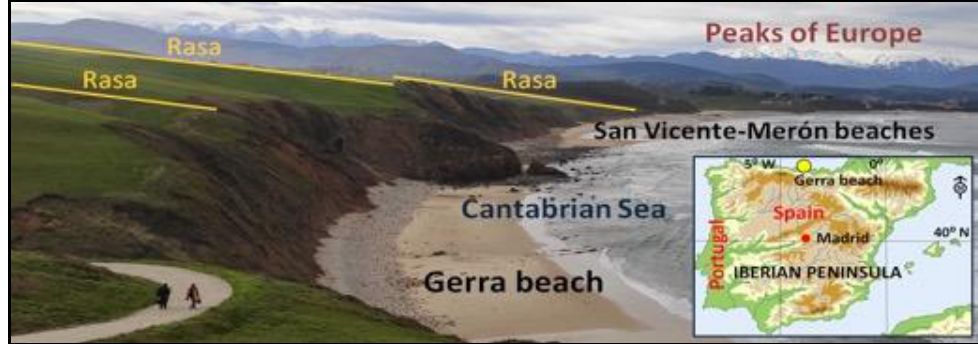
Figure 1. Gerra beach and San Vicente-Merón beaches system from the east of abrasion platform “rasas”.